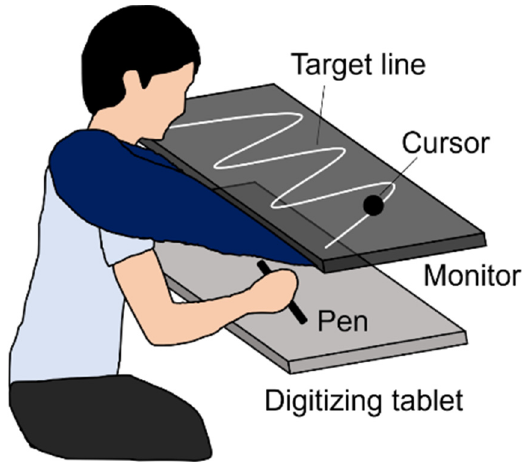
Figure 2. Experimental